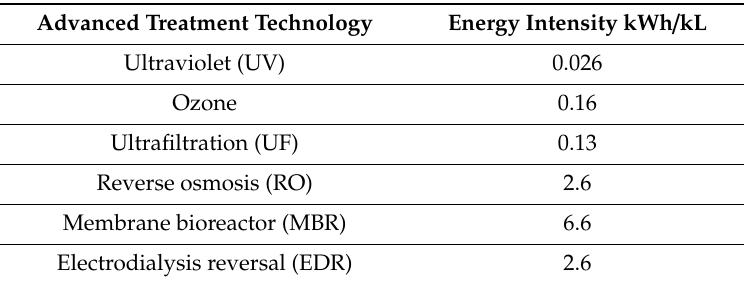
Table 6. Typical energy intensity of advanced water treatment technology (adapted from